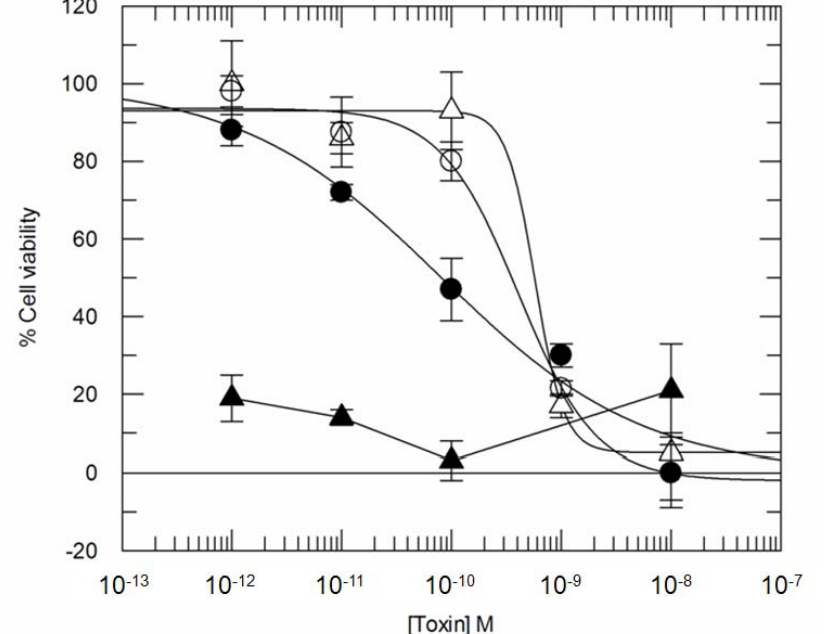
compared Figure 5. Seventy-two hour Cytotoxicity of ITxs CD7-SAP and CD7-SAP KDEL to ricin either in the presence or in the absence of BFA. Cells were pre-incubated with BFA at 0.05  g/mL 30 min before the addition of toxins and then further incubated for 72 h. Percent cell viability refers to control untreated cells. Samples have been performed in ○ ● ∆ ▲ triplicate. Symbols refer to: CD7-SAP, CD7-SAP + BFA, CD7-SAP , KDEL CD7-SAP + KDEL